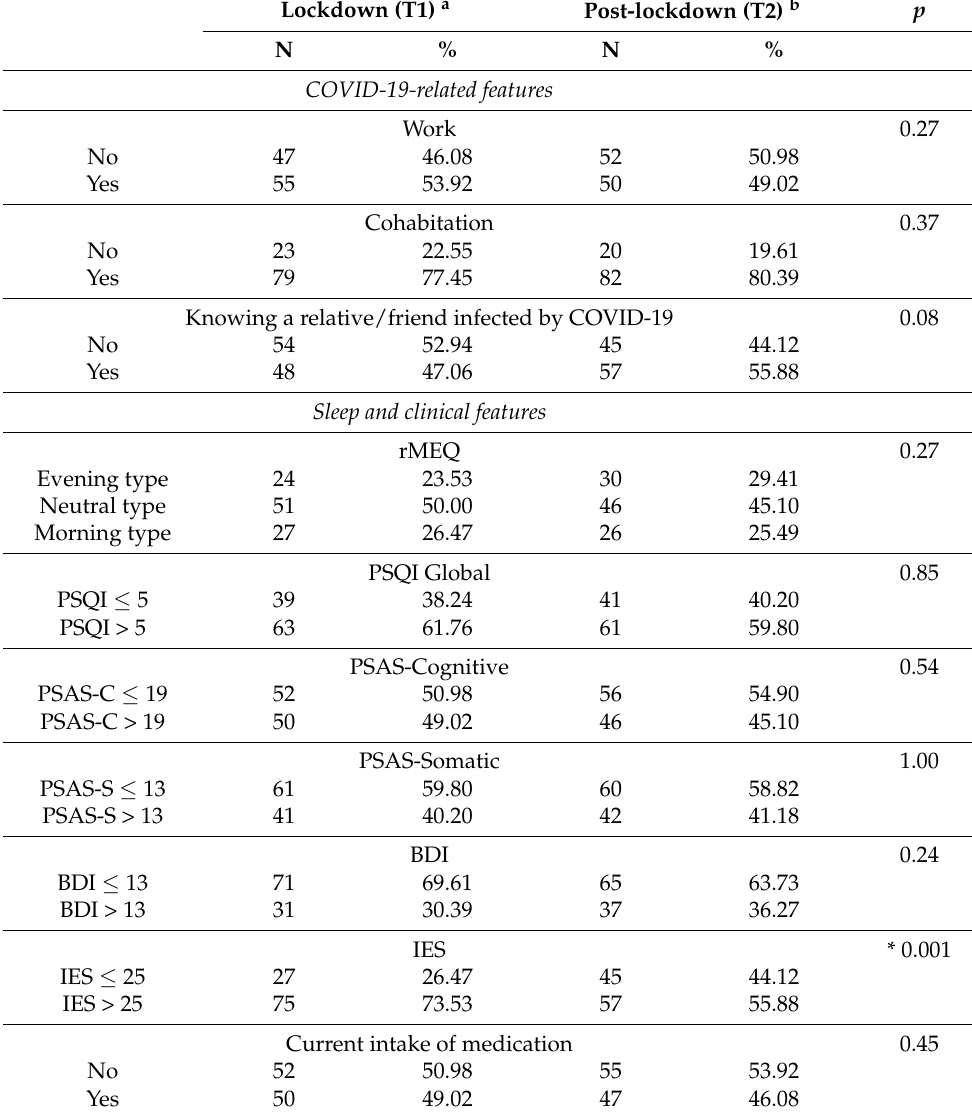
Table 2. Proportion of participants concerning COVID-19-related, sleep, and clinical variables during (T1) and after (T2) the lockdown. Results ( p -values) of the McNemar tests were also reported. Asterisks mark significant differences ( p <